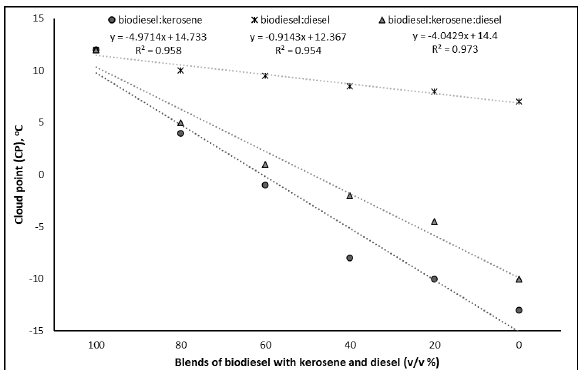
Fig. 2. Effect of Neem biodiesel ratio on CP of biodiesel: kerosene, biodiesel: diesel and biodiesel:kerosene:diesel